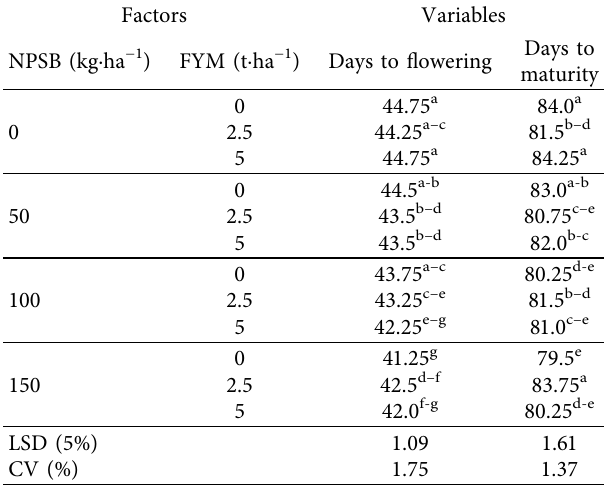
Table 3: Days to fowering and physiological maturity as afected by NPSB and FYM